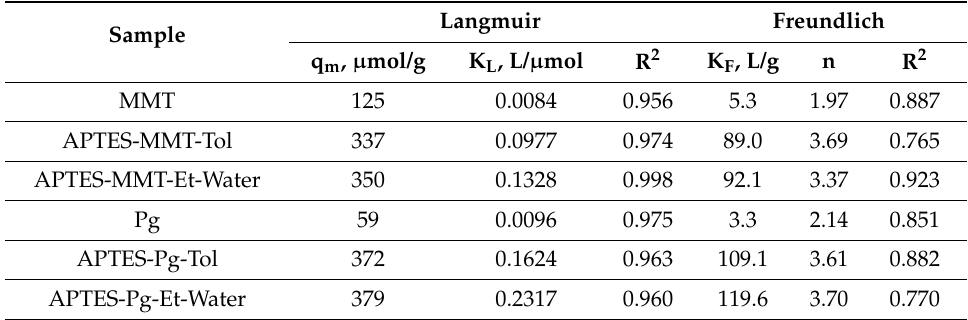
Table 2. Langmuir and Freundlich parameters for the adsorption of uranyl ions onto pristine and APTES-modified minerals.